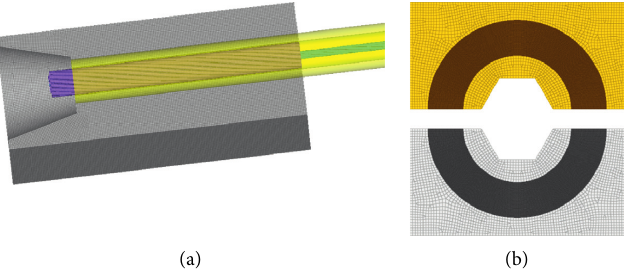
Figure 11: A finite element model for the crimping process of the stamper, aluminum pipe, and aluminum strand: (a) overall view; (b) cross- sectional